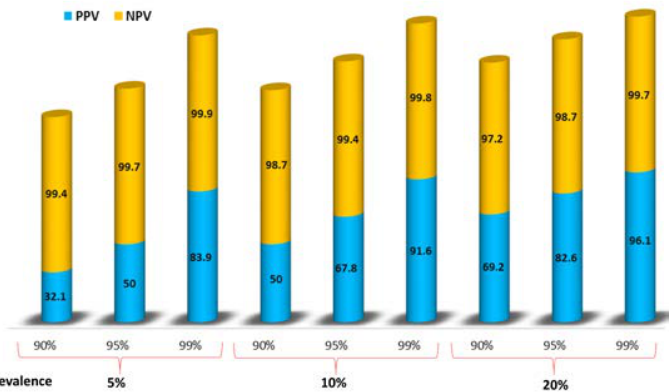
Fig. 2. Positive predictive values (PPV) and negative predictive values (NPV) of COVID-19 testing at different prevalence levels of the disease and diagnostic sensitivity and specificity of the